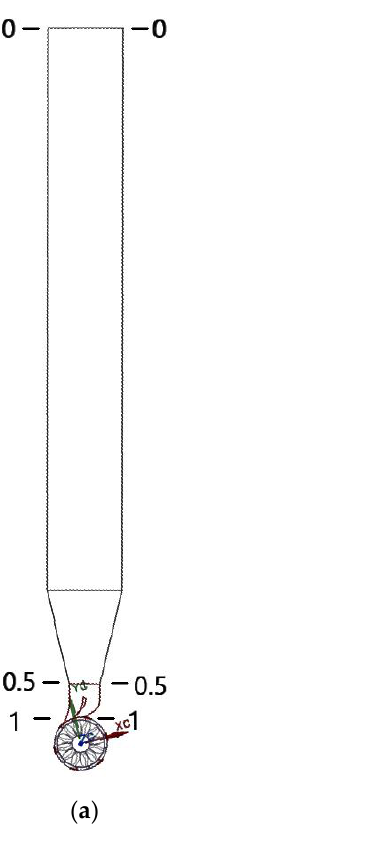
Figure 1. Section numbers for: ( a ) the exhaust pipes and the first-stage nozzle guide vanes; ( b ) the first-stage rotor outlet, the inter-stage pipes, the second-stage nozzle vanes and the second-stage rotor outlet.